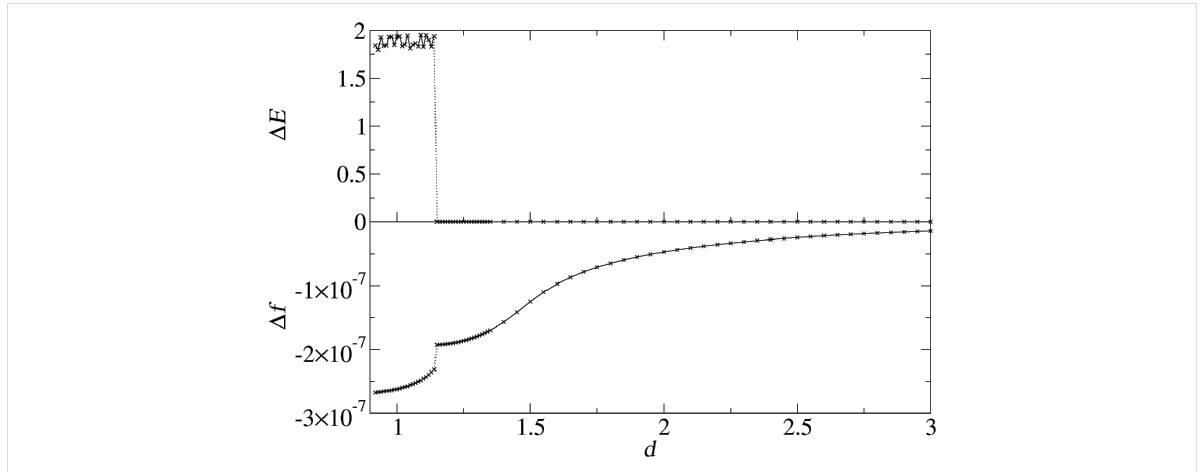
Figure 4: Energy dissipation and frequency shift as a function of the nominal distance. Each point is calculated by a single simulation run with shifted z 0 . Lateral tip position is set to A of Figure 2.